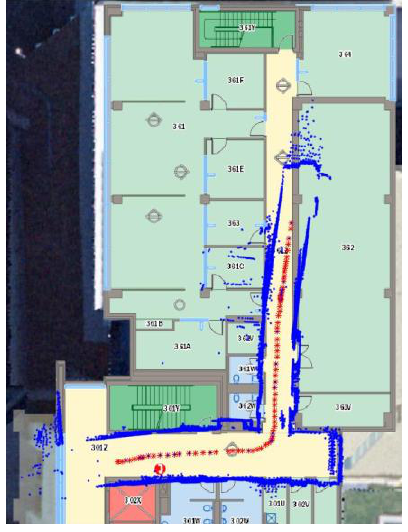
Figure 6. Mapping and position results of the ICP algorithm. Three level multi-resolution map representations, using grid cell dimensions 20, 10, and 5 cm, have been utilized to evaluate Hector SLAM approach. Figure 7 shows the mapping and position results using Hector SLAM of resolution 5 cm. The blue points represent the constructed map, while the red asterisks represent the vehicle’s trajectory. It also suffers from the same problem and for the same reason. The Hector SLAM method estimates 65.2% of the actual length.